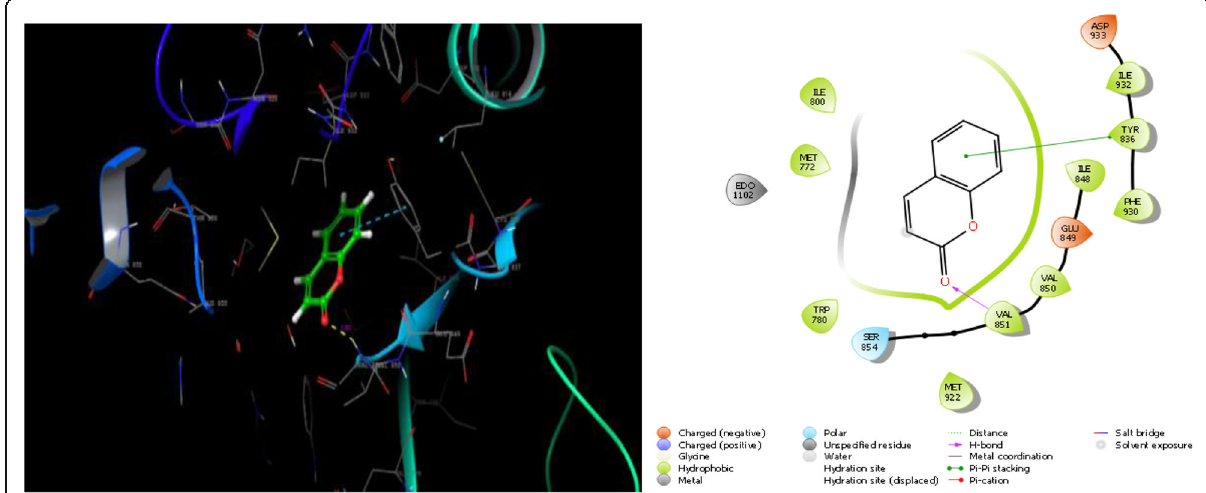
Fig. 4 Interaction of coumarin with PIK3C α , both 3D and 2D diagrams, is given below with yellow dotted line in 3D figure represents H-bond